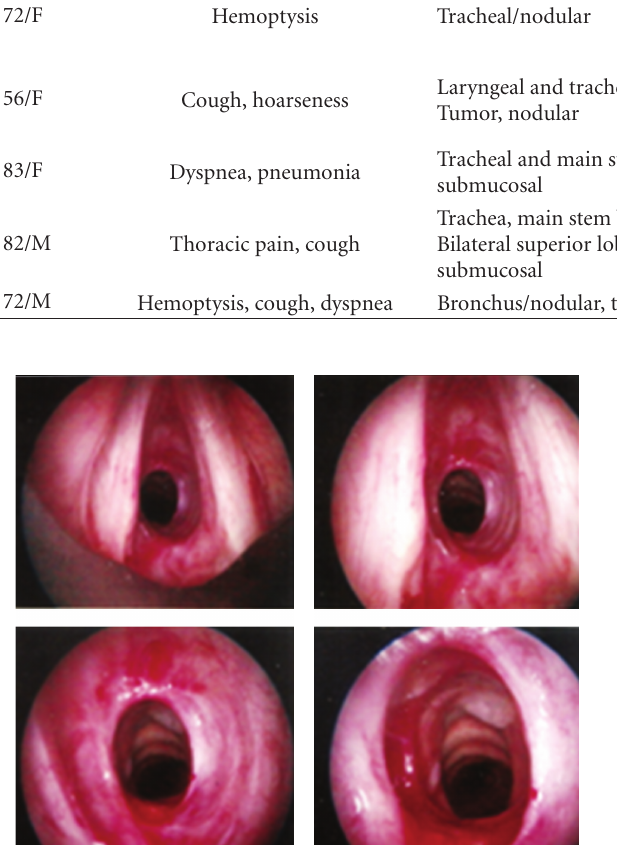
Figure 5: On bronchoscopy, this is the appearance of debulking with laser therapy; the left tracheal wall is edematous and